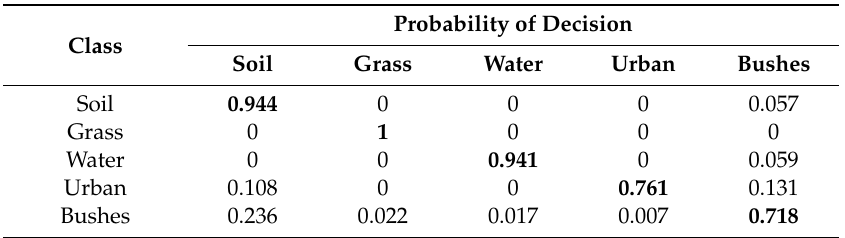
Table 20. Classification probabilities (confusion matrix) for the NN-based method trained for original image and applied to the compressed image (PSNR-HVS-M = 36 dB).